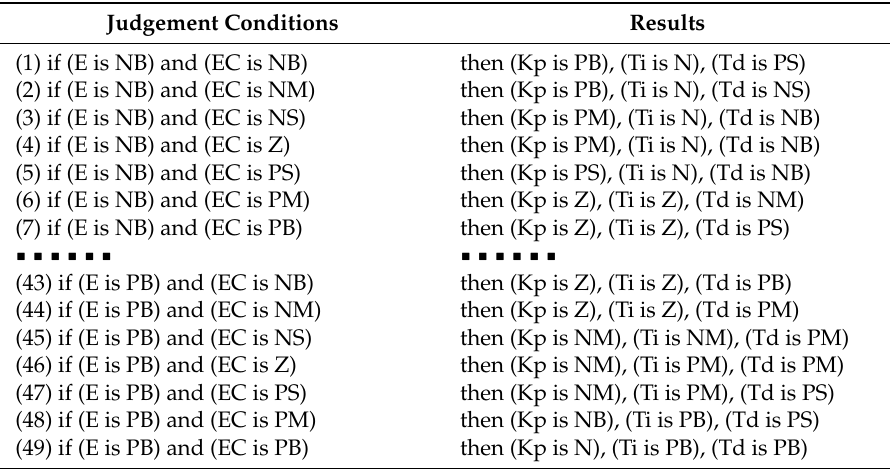
Table 1. Fuzzy logic control